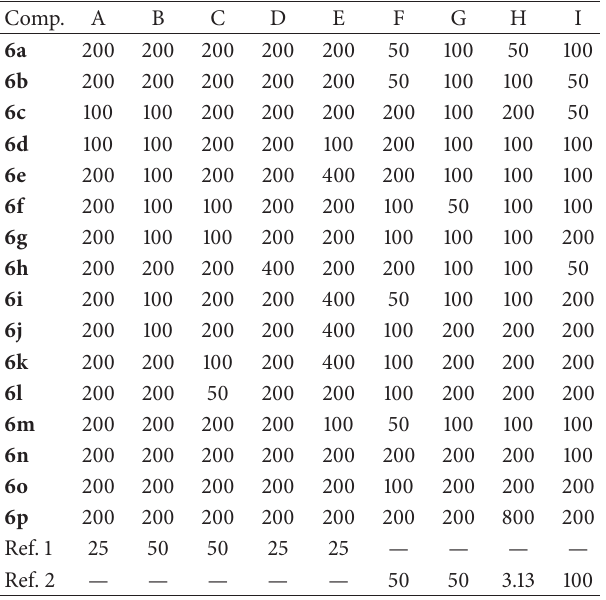
Table 1: Antimicrobial activity of the compounds 6a – 6p (MIC, 𝜇 g/mL). Comp.